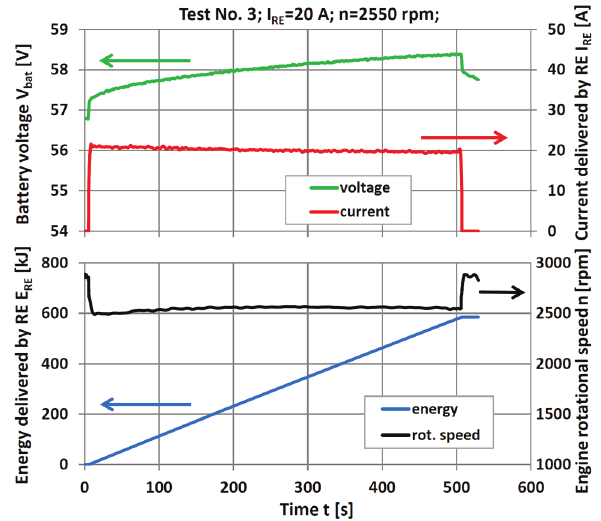
Table 2. Summary of the results of measurements of an overall efficiency Parameter